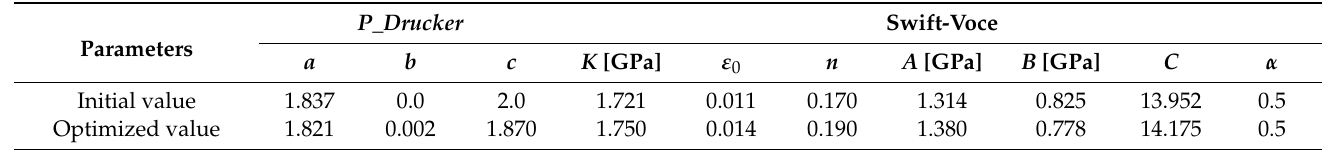
Table 4. Constitutive model optimization by inverse